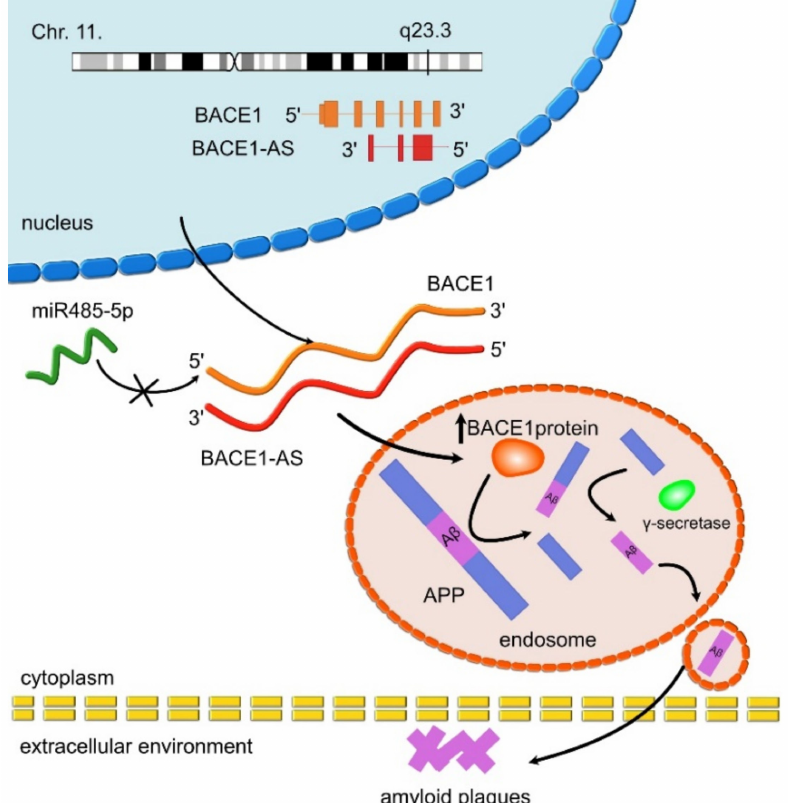
Figure 4. BACE1-AS involvement in AD pathophysiology. The BACE1-AS locus is localized on chromosome 11 (www.genecards.org, accessed on 28 April 2021). Its product binds to BACE1 , stabilizing this mRNA and masking a binding place for miR485-5p, which normally inhibits the BACE1 enzyme translation. In this way, BACE1 leads APP into the amyloid pathway, increasing the production of the A β aggregates into the amyloid